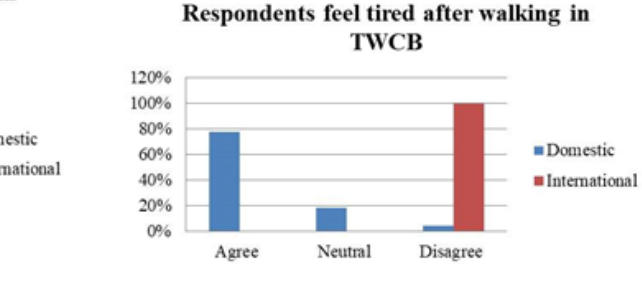
Fig. 6 Respondent’s feeling when walking in TWCB Source: Author